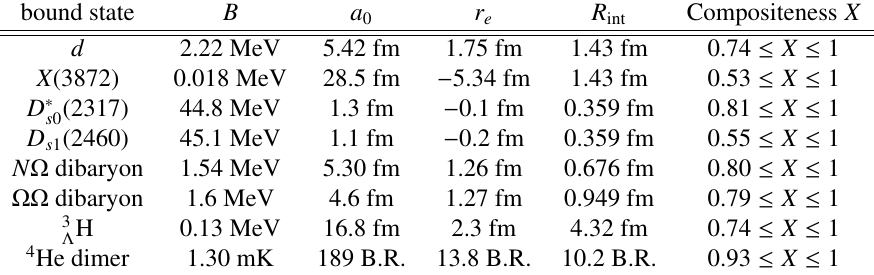
Table 1. The physical quantities and the compositeness X with the uncertainty band (7). u, mK and B.R. stand for the atomic mass unit, millikelvin and the Bohr